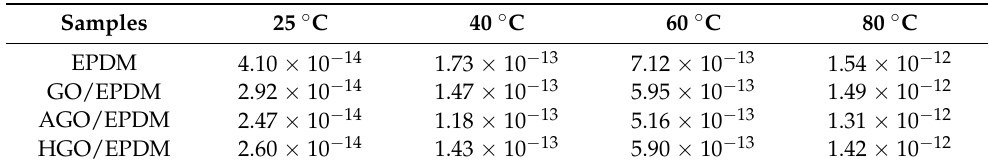
Table 2. Summary of diffusion coefficients (m 2 /s).